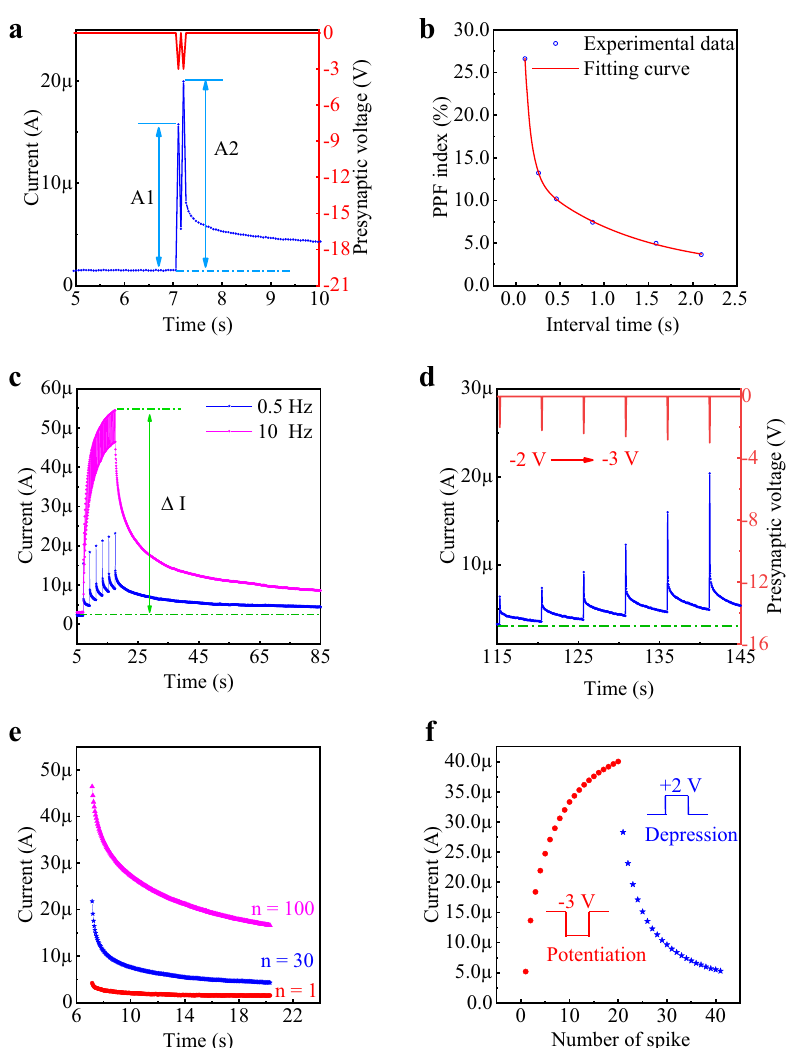
Fig. 4 Long-term plasticity. a EPSCs triggered by two identical spikes, with an interval of 104 ms. Amplitudes of the fi rst and second EPSCs are A1 and A2, respectively. b PPF index versus time interval between two successive input pulses. c Current change at different frequency of pulse stimulations. d EPSCs triggered by a series of different presynaptic spikes from − 2 to − 3 V in step of − 0.2 V. e Postsynaptic current versus time stimulated by different number of presynaptic spikes. f Potentiation and depression triggered by 19 negative and 21 positive